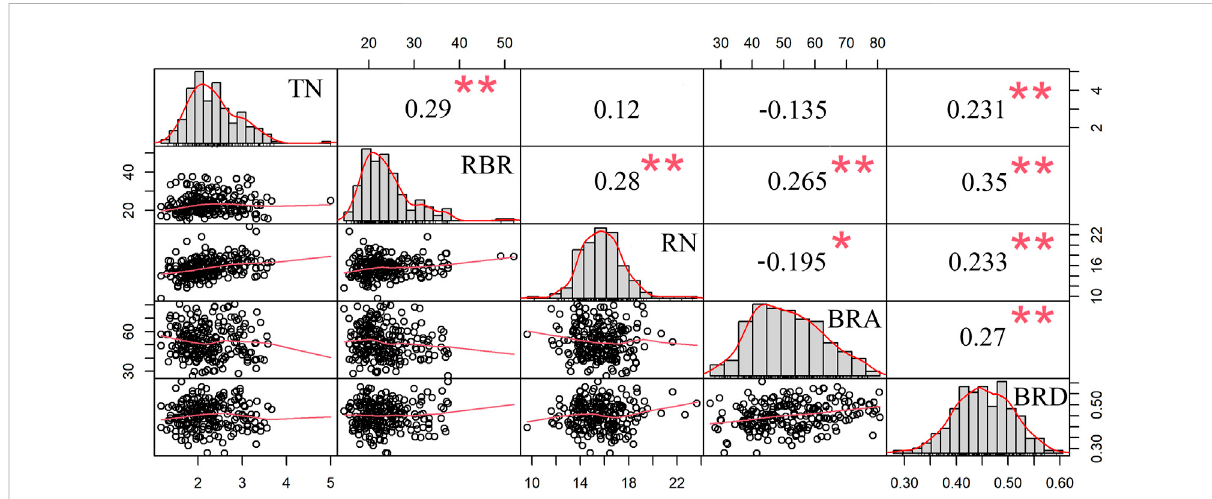
FIGURE 5 Correlations between BRA, BRD and three other brace root traits. The diagonal plot represents the frequency of the phenotypic distribution between the brace root angle, the brace root diameter, and the other three brace root traits. The value above the diagonal is Pearson ’ s correlation coef fi cient betweenthe two traits. Below the diagonal is ascatter plotof two traits. * represents signi fi cant difference at the0.05 level;** represents signi fi cant differences at the 0.01 level. BRA , brace root angle, BRD , brace root diameter, TN , tier number of the brace root, RBR , radius of the brace root, RN , number of the brace